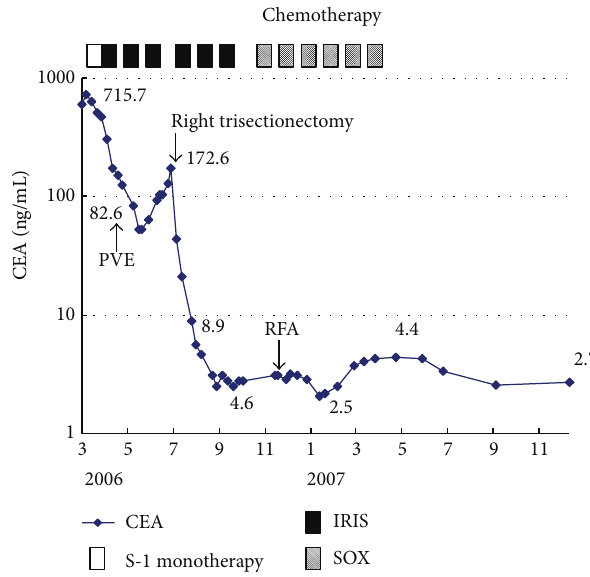
Figure 2: The time course of serum CEA level. S-1 monotherapy: S-1 120mg/day for 2 weeks; IRIS: day 1 CPT-11 160mg/body; TS- 1 120 mg/body for 2 weeks followed by a 2 week rest period; SOX: day 1 Oxaliplatin 120mg/body, TS-1 120 mg/body for 2 weeks followed by a 2-week-rest period. PVE: portal vein embolization; RFA: radiofrequency ablation